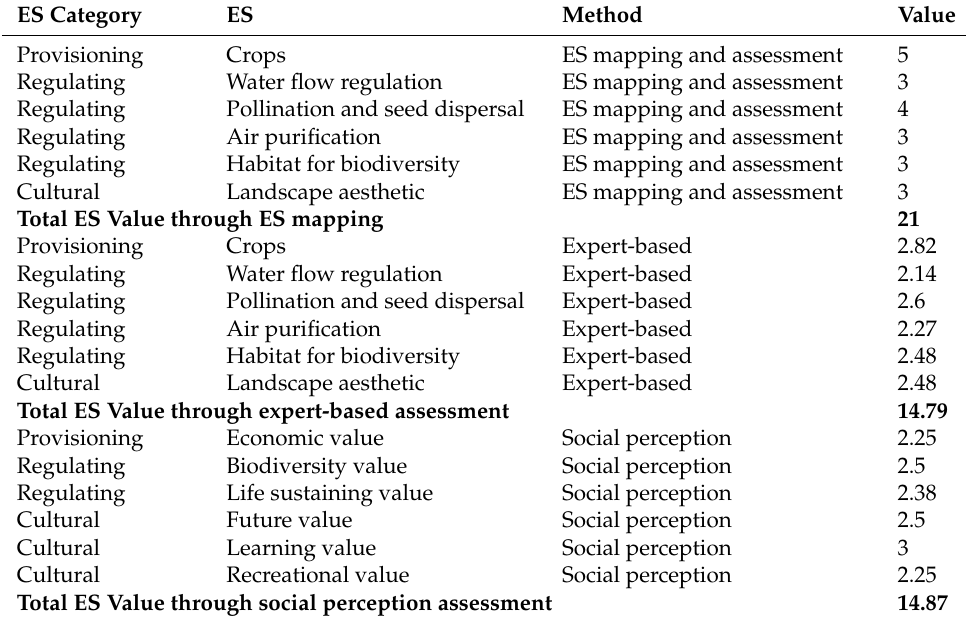
Table 1. Six most ranked ES values per methodology. The columns identify the category and typology of ES, the methodology used for their assessment and the value